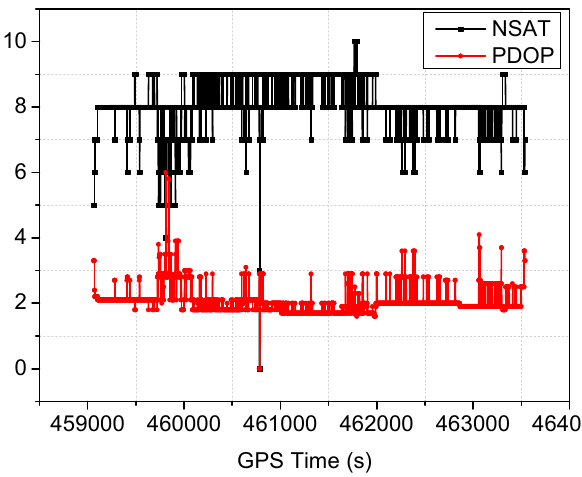
Figure 3. The number of visible satellites and PDOP during the test.